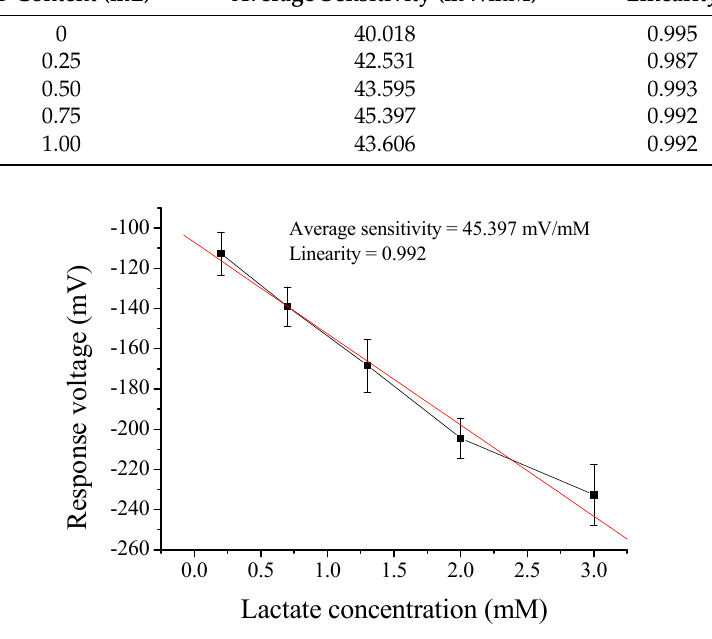
Figure 5. The response voltages of flexible arrayed lactate biosensor modified by 0.75 mL MBs.